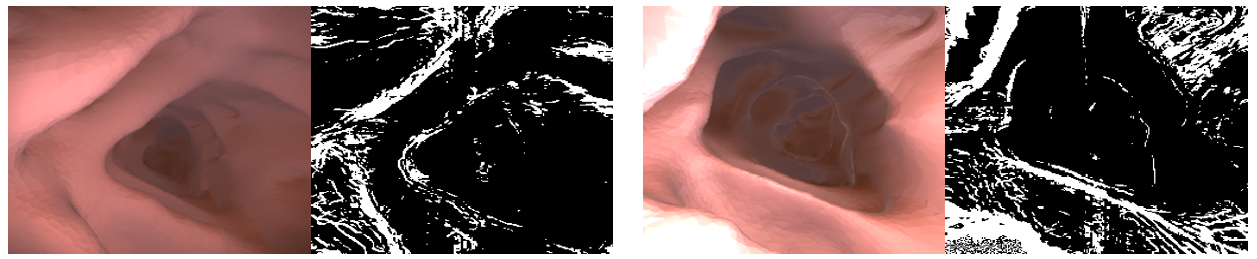
Figure 4. Auto-masking. Shows the auto-masking result learned in the experiment. Most of the colonoscopy images are flat areas and are calculated as black ( µ = 0 ) by auto-masking, and photometric loss is calculated based on the edge or textured area ( µ = 1 ) .